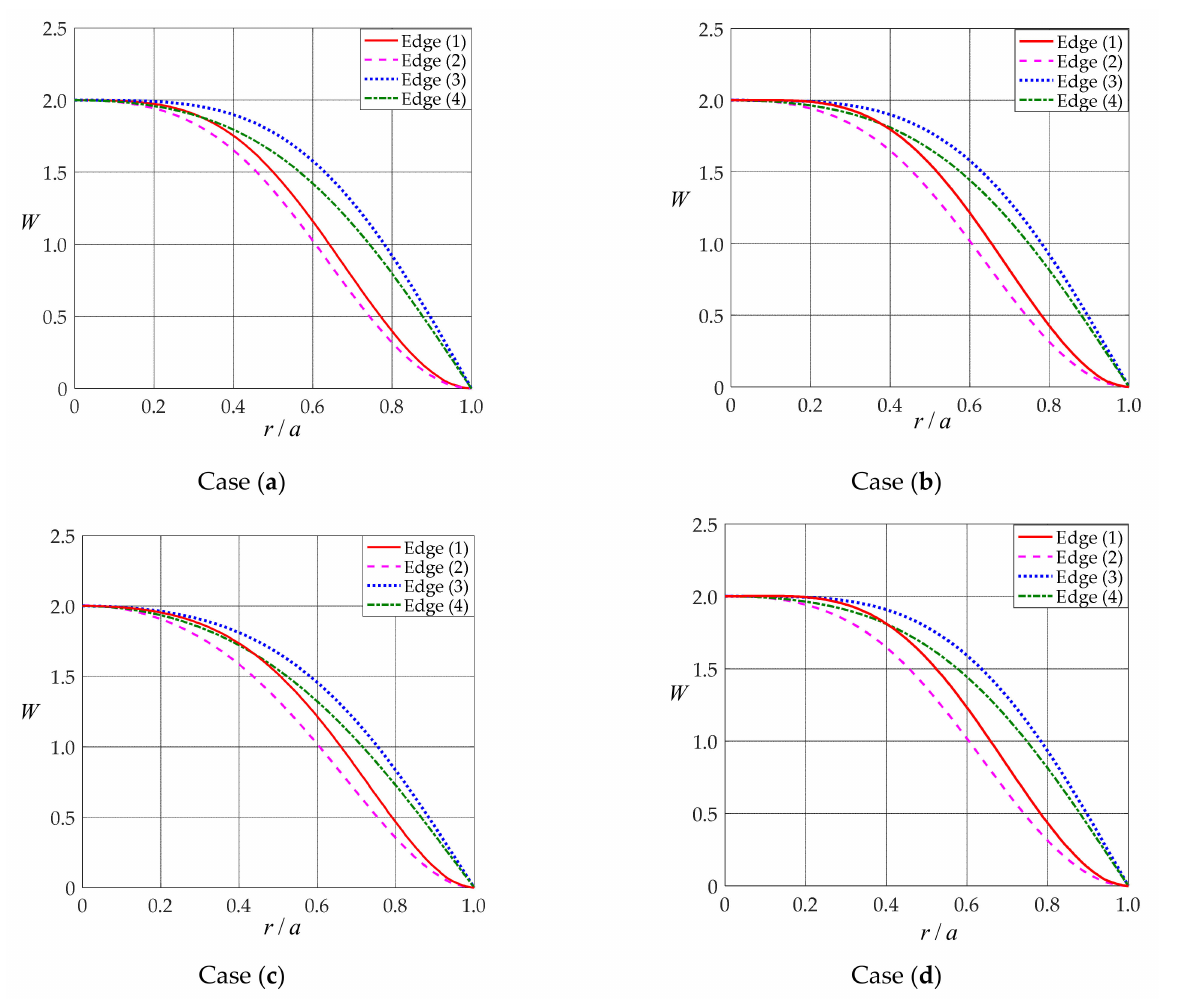
Figure 4. Variations of W with r/a : Case ( a ), α 1 = 0.5, α 2 = 0.1; Case ( b ), α 1 = − 0.5, α 2 = − 0.1; Case ( c ), α 1 = 0.5, α 2 = − 0.1; and Case ( d ), α 1 = − 0.5, α 2 =